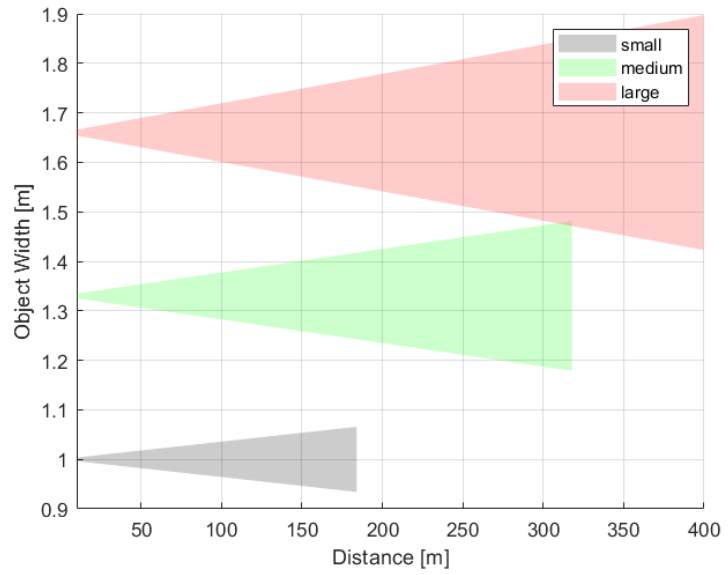
Figure 9. The quantization uncertainty of P W with respect to the distance. The calculations were made for average birds representative of each class, i.e., 1 m, 1.32 m, and 1.67 m wingspans representative of small, medium, and large bird classes,